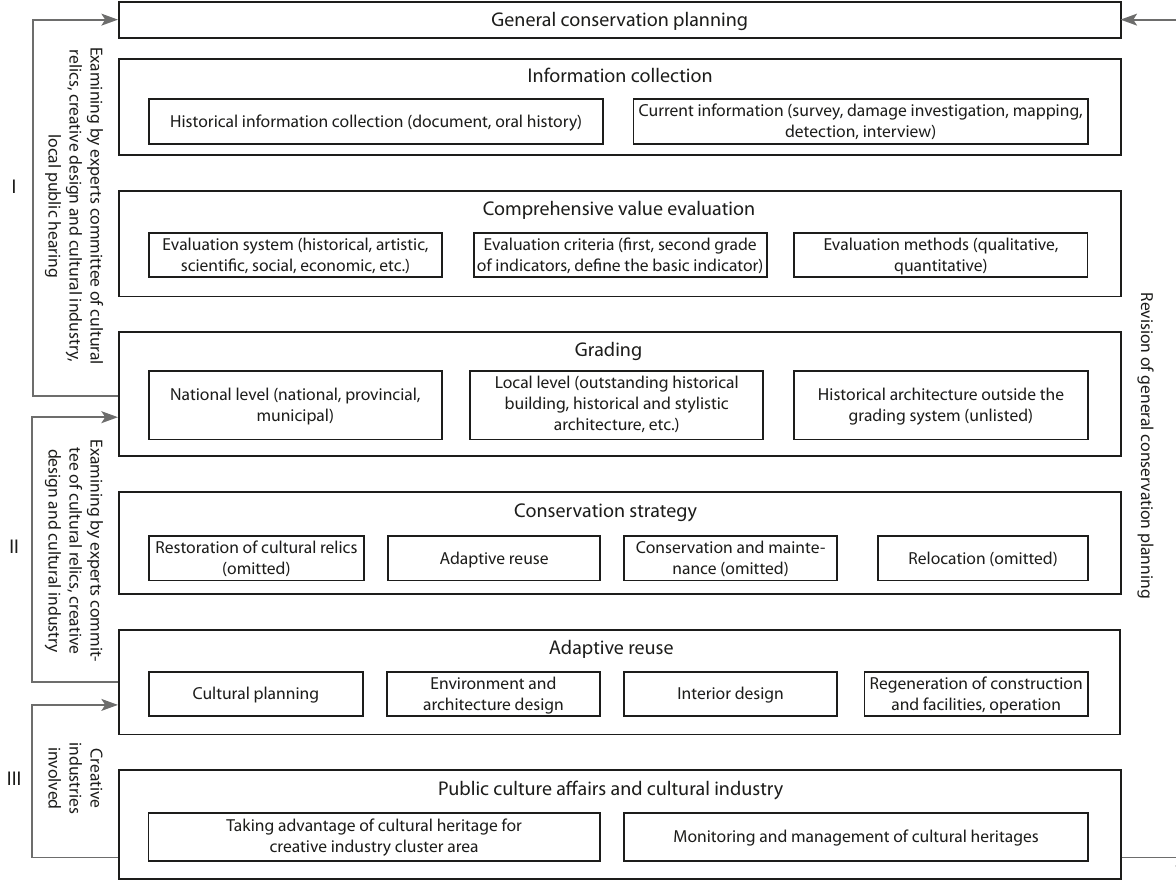
Figure 14 Procedures for historical architecture reconstruction and regeneration (Source: Subin